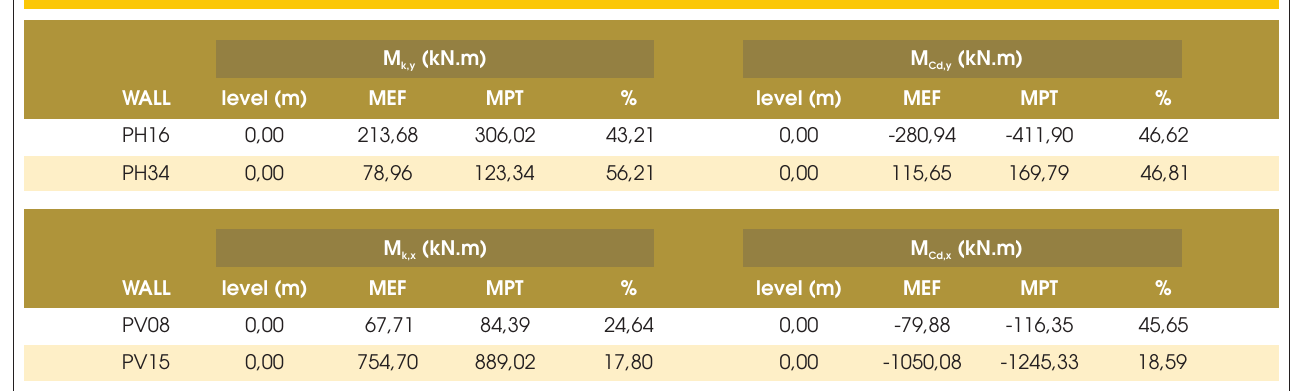
k,y , on the walls PV08 and PV15 k,x